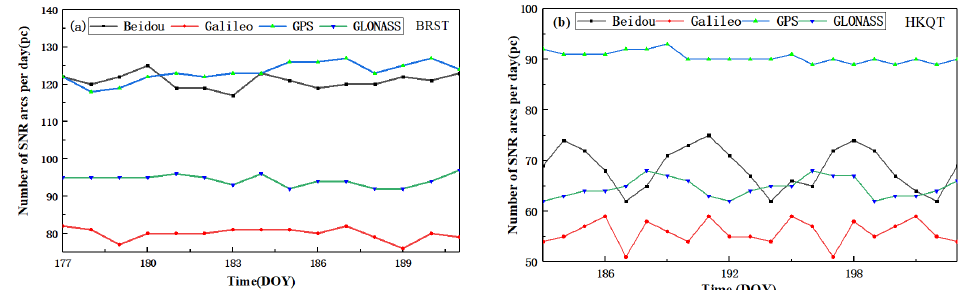
Figure 1. Number of available SNR arcs per day: ( a ) for the BRST station, the number of available SNR arcs from quad-constellation per day during DOY 177–191 2021; ( b ) for the HKQT station, the number of available SNR arcs from quad-constellation per day during DOY 183–203 2021.